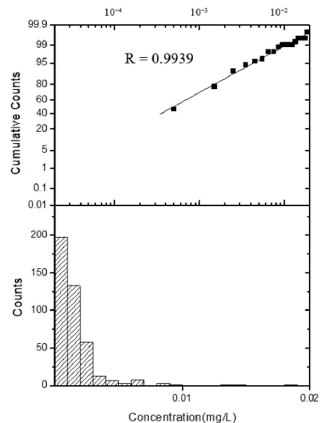
Figure 3. Statistical distribution of detected daily average concentrations of As of the WWTPs.